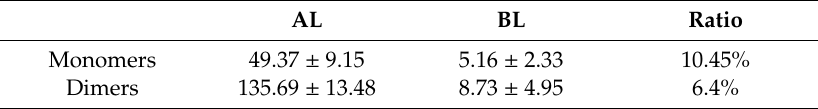
Table 1. The absorption rate of BLPs by Caco-2